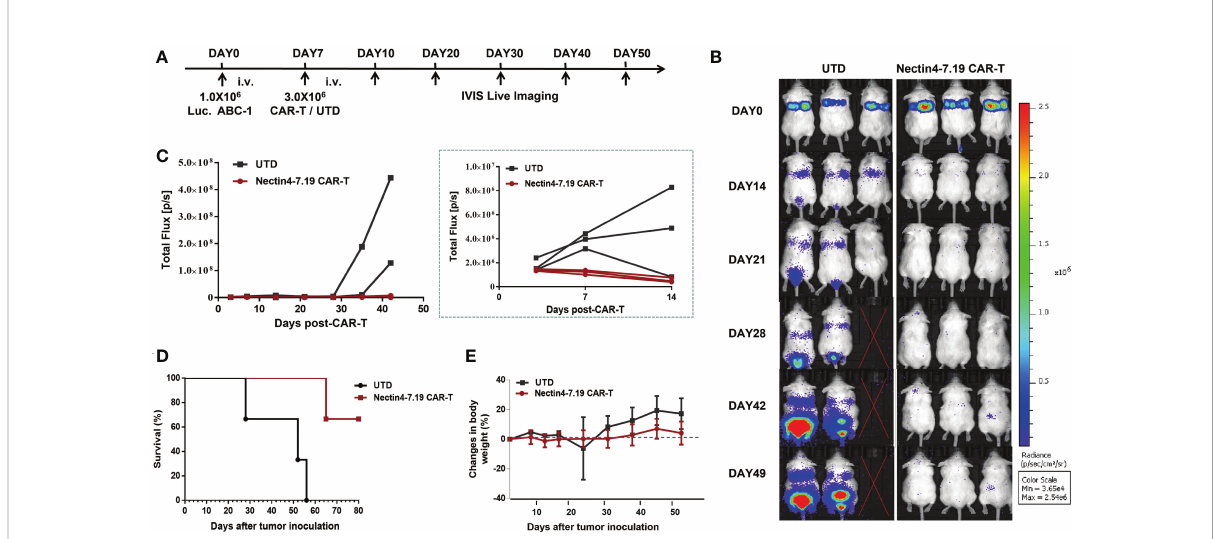
FIGURE 5 Signi fi cant anti-tumor effect of Nectin4-7.19 CAR-T therapy on metastatic lung cancer without on-target off-tumor toxicity. (A) NSG mice were i.v. inoculated with 1.0 × 10 6 Luc. ABC-1 cells on Day 0 and received an administration of 3 × 10 6 Nectin4-7.19 CAR-T cells on Day 7 ( N = 3 mice per group). Mice treated with the same dosage of UTD cells served as a negative control. (B – D) Tumor xenografts were monitored via bioluminescence imaging. Representative bioluminescence images of three independent experiments are shown in (B) ; bioluminescence kinetics are shown in (C) ; solid lines represent each individual mouse. Kaplan – Meier survival curve is shown in (D) , p = 0.0246 (Nectin4-7.19 CAR-T vs . UTD), N = 3, log-rank test. (E) Body weight of mice since the tumor